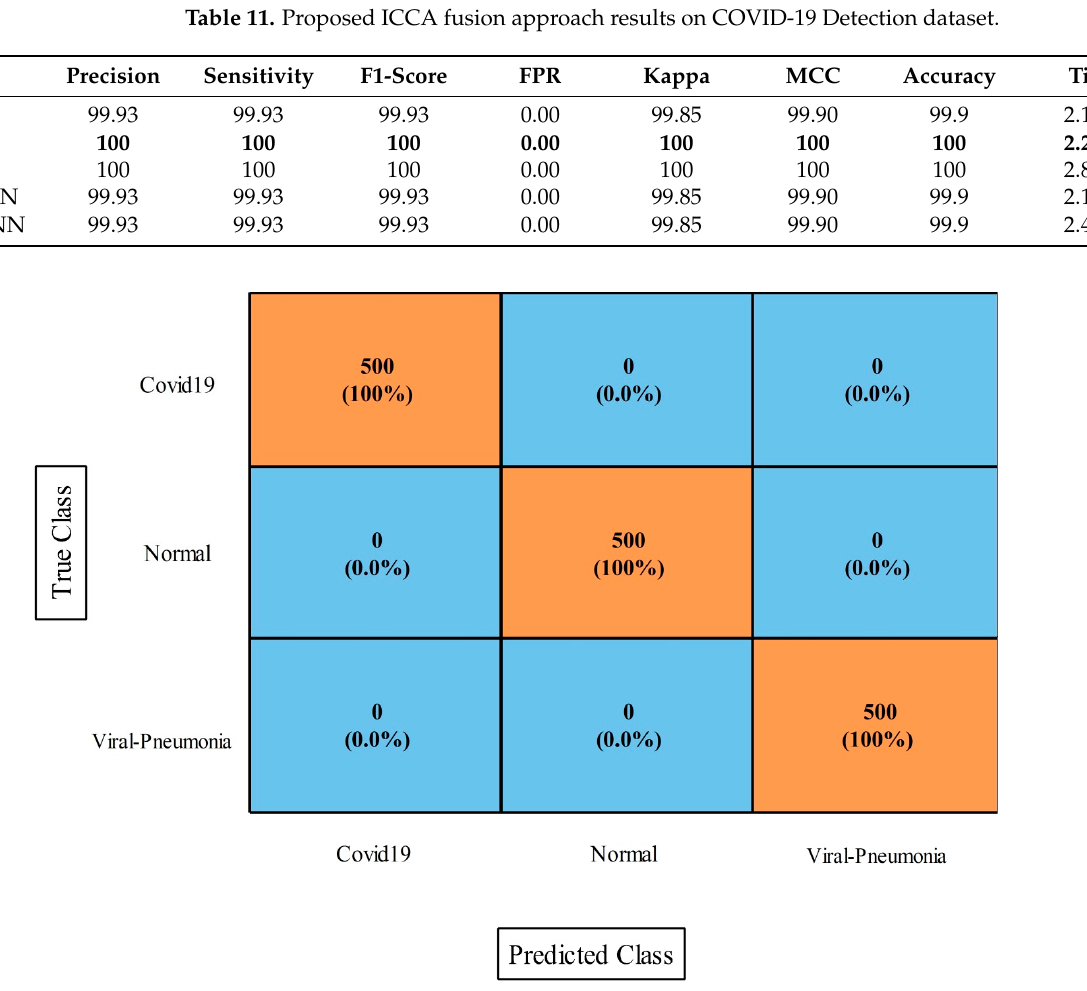
Figure 14. Confusion matrix of MNN learner on COVID-19 Detection dataset. Table 12. Proposed ICCA fusion approach results on COVID-19 Detection dataset.